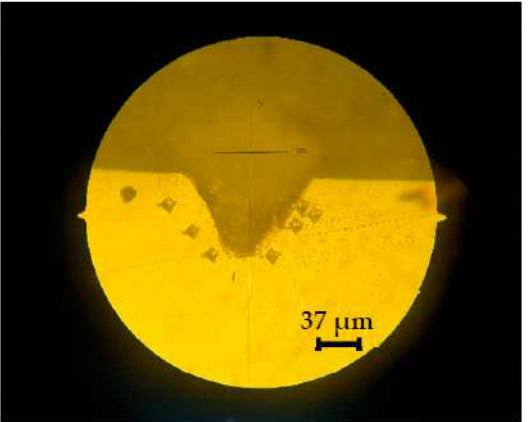
Figure 2. Image of the microhardness measurements on the adjacent zone to the texturing.